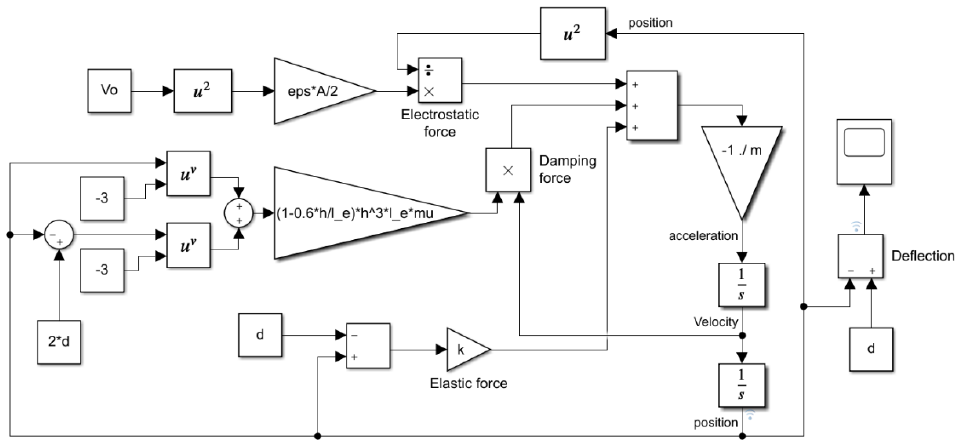
Figure 6. The MATLAB/Simulink model corresponding to the system equation of motion, Equation (6).